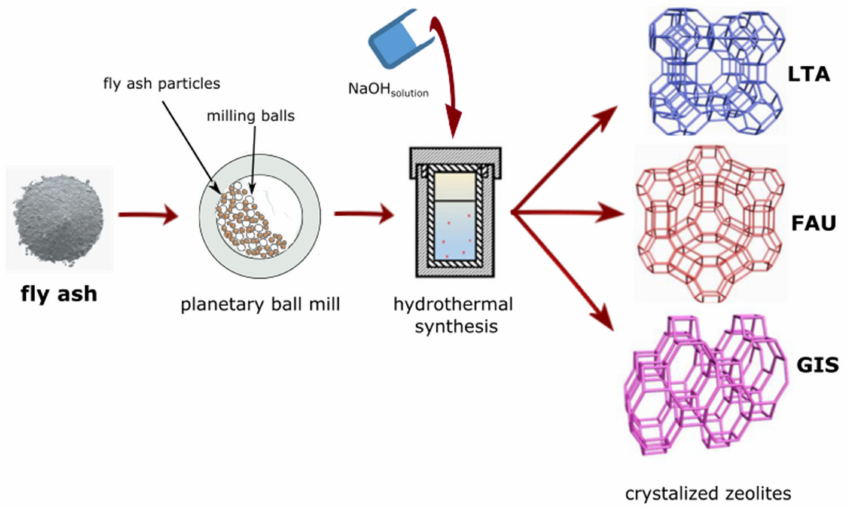
Figure 1. Graphical summary of zeolite phase formation by mechanochemically assisted coal fly ash